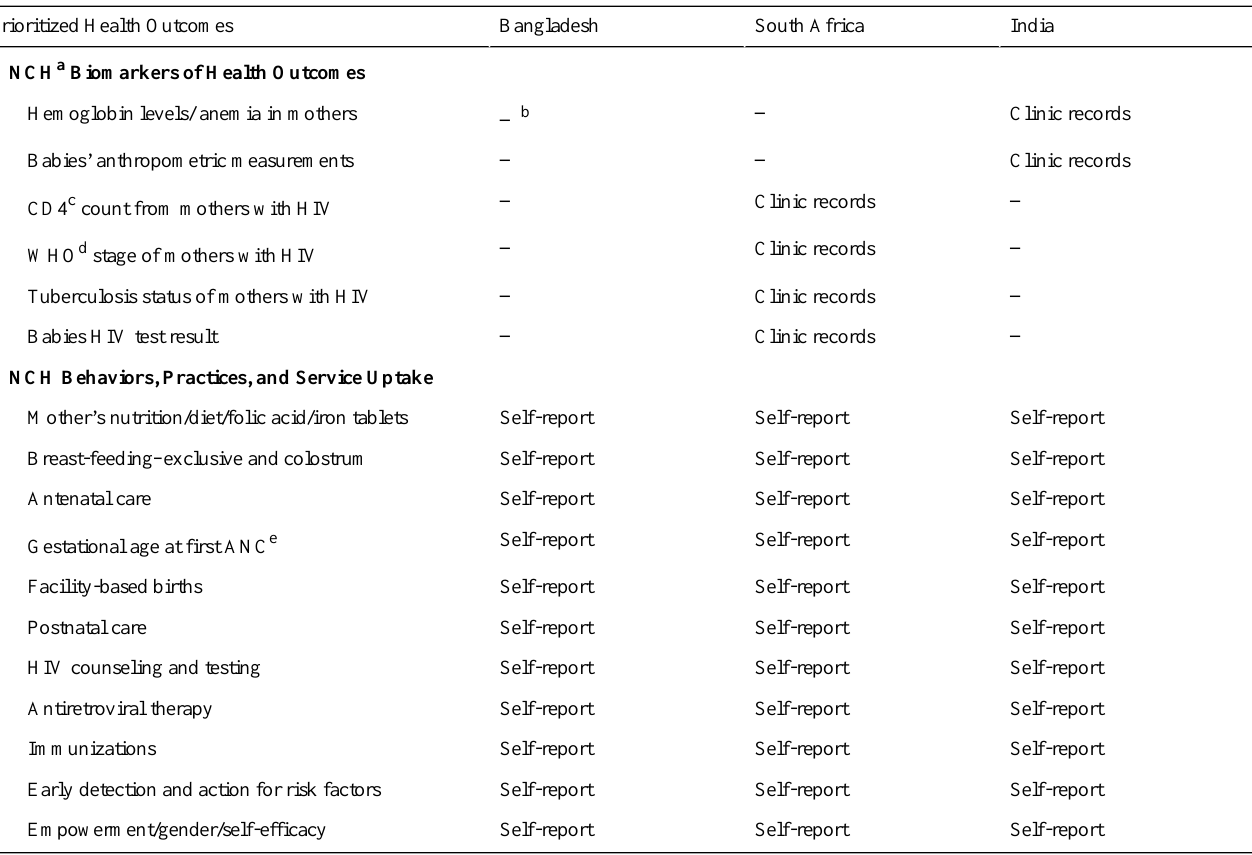
Table 1. Prioritized health and behavior outcomes for Mobile Alliance for Maternal Action programs in Bangladesh, South Africa, and India with data